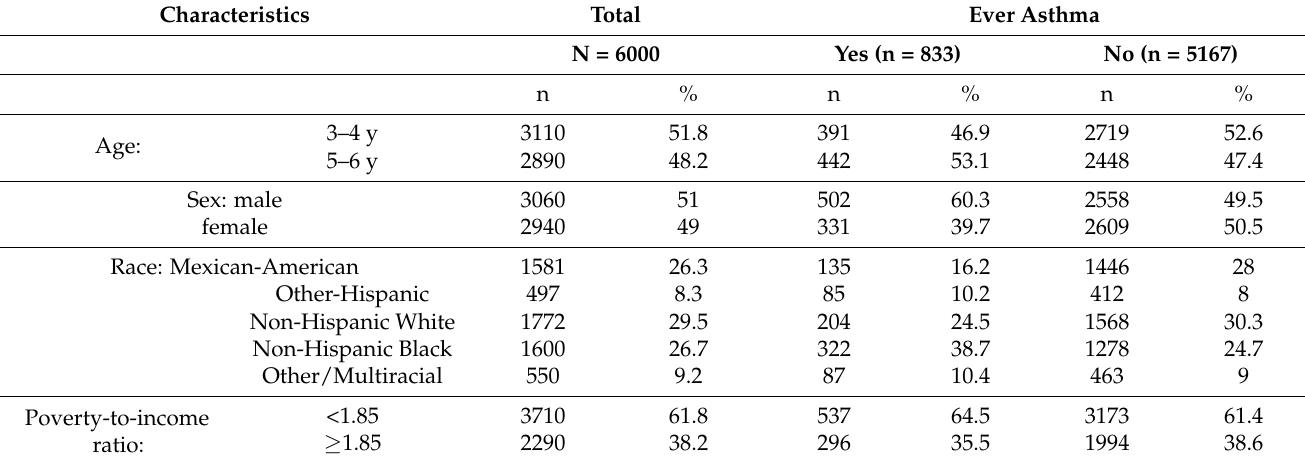
Table 1. Clinical characteristics of the study participants and univariate analysis of the risk of